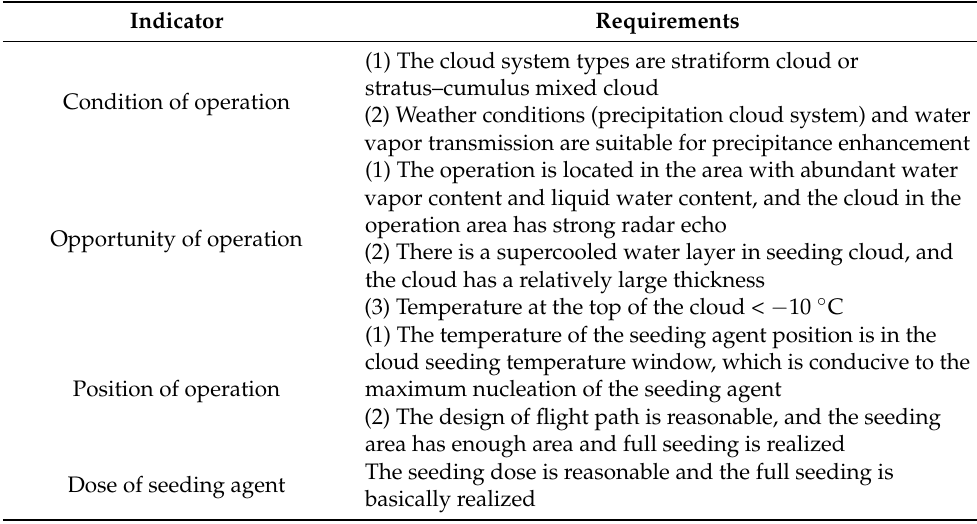
Table 1. Reasonableness condition of artificial precipitation enhancement